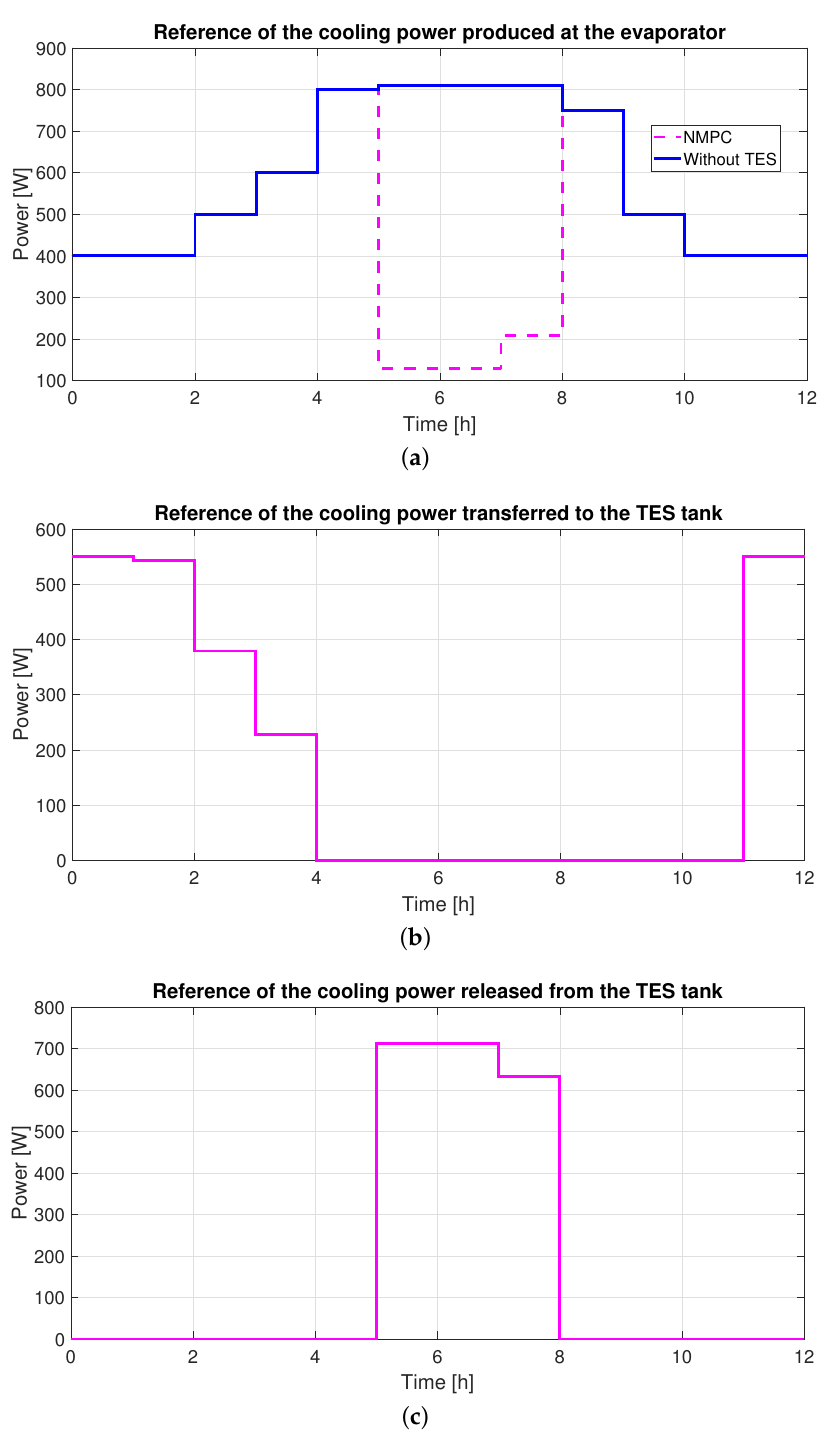
Figure 13. References on the relevant cooling powers for both the proposed scheduling strategy for the TES-backed-up system and the refrigeration cycle without energy storage. ( a ) Reference on ˙ Q e , sec . ( b ) Reference on ˙ Q TES . ( c ) Reference on ˙ Q TES , sec